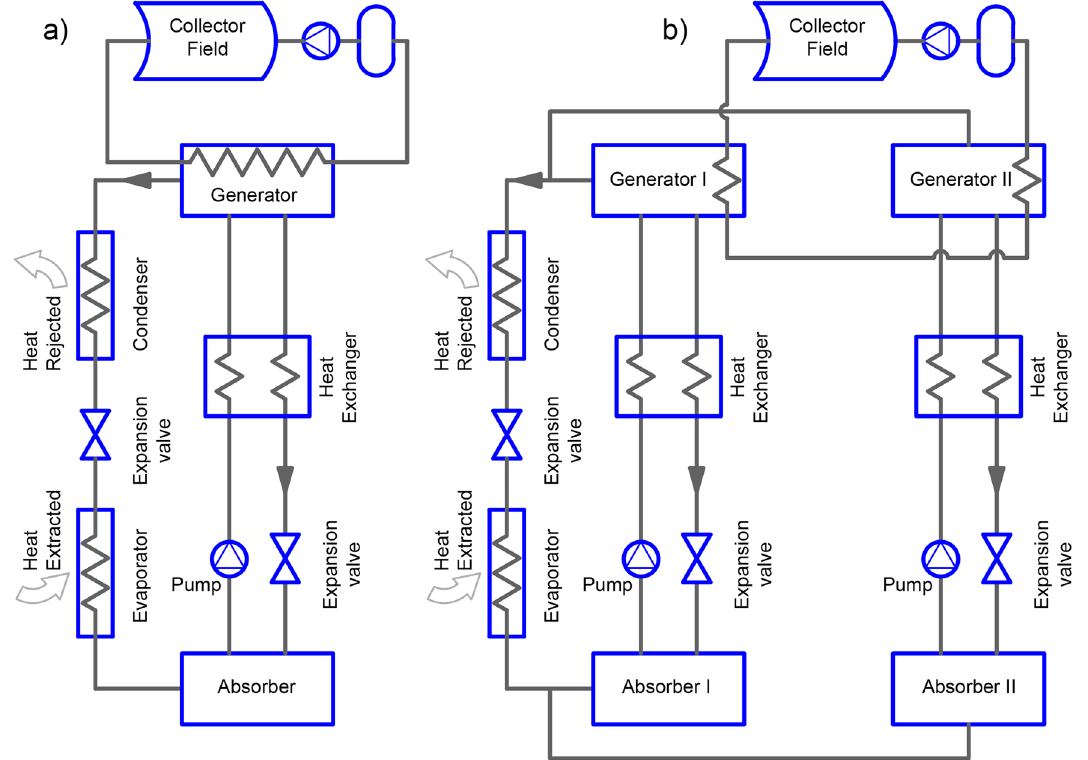
Figure 12: Solar - assisted absorption diagrams: ( a ) single e ff ect, ( b ) double e ff